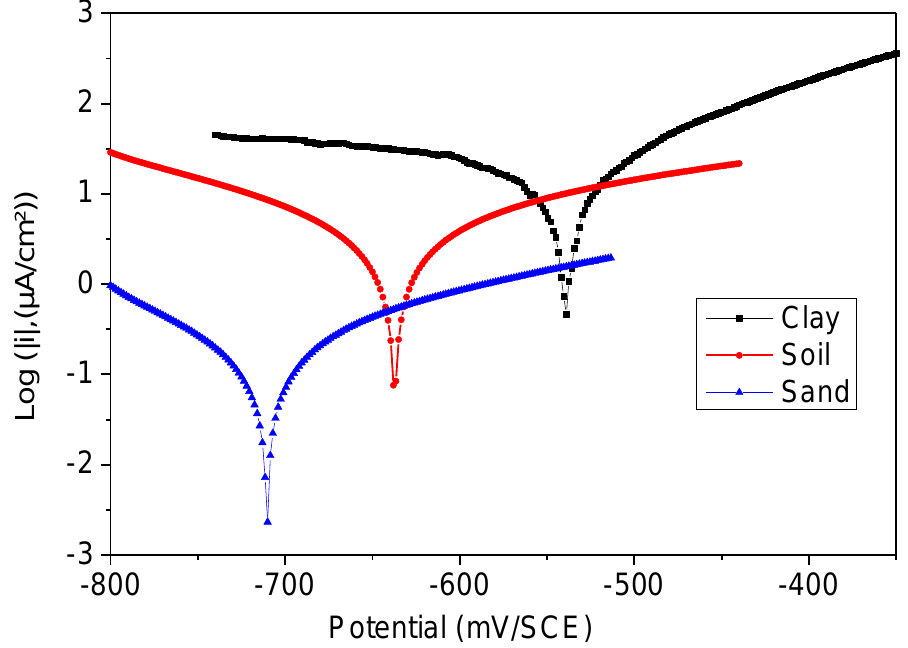
Figure 4. Polarization curve (Tafel) of the coated steel in the different soil extracts, clay, soil, and sand. Table 3. Electrochemical parameters and corrosion-inhibiting efficiency of the coated steel.